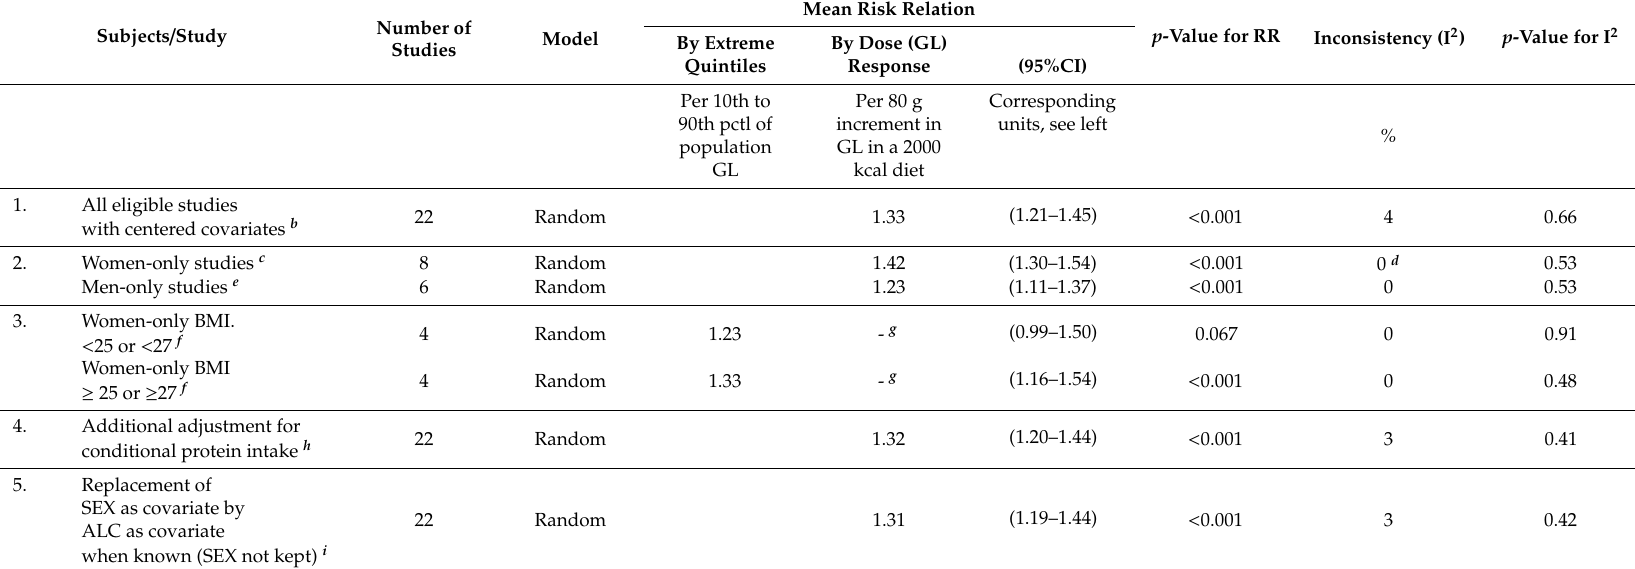
Table 5. Type 2 diabetes–glycemic load risk relations combined by a meta-analysis of the results of published prospective cohort studies, with model adjustments for covariates of SEX, CORR, ETH, and FUY except when specified otherwise in the first column and / or footnote a